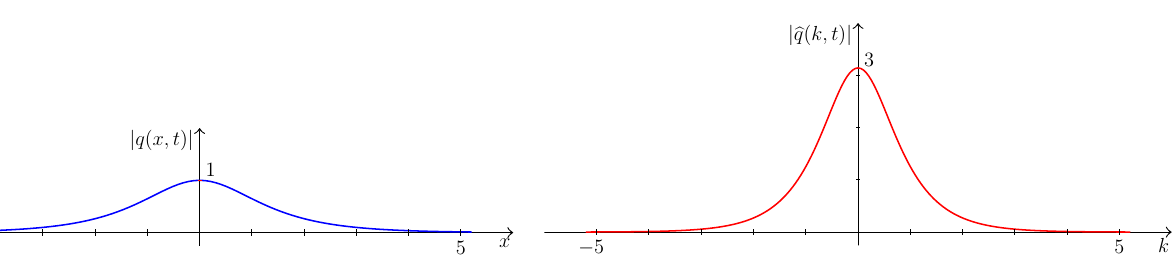
Figure 2. The moduli of the NLS bright soliton (left panel, blue curve) and its corresponding spectrum (right panel, red curve). Although both profiles are secant hyperbolic, the former is wider and shorter, whereas the latter is narrower and taller. Both plots are depicted on the same axis